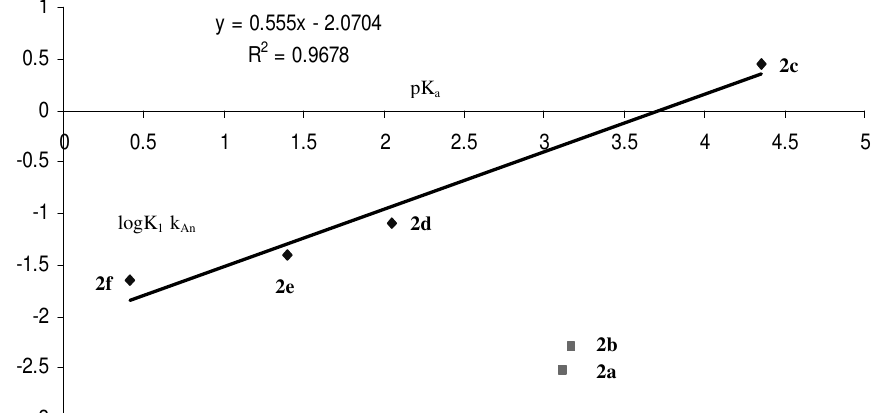
Figure 2. Plot of log K k for the reaction of 1 with anilines versus the pK 1 An corresponding anilinium ions. ( The slope is 0.55. Points a, b, c, d, e and f represent 2,6-Et, 2,6-Me, 2,4-Me, 2-F, 2-Cl, 2-CN-anilines respectively